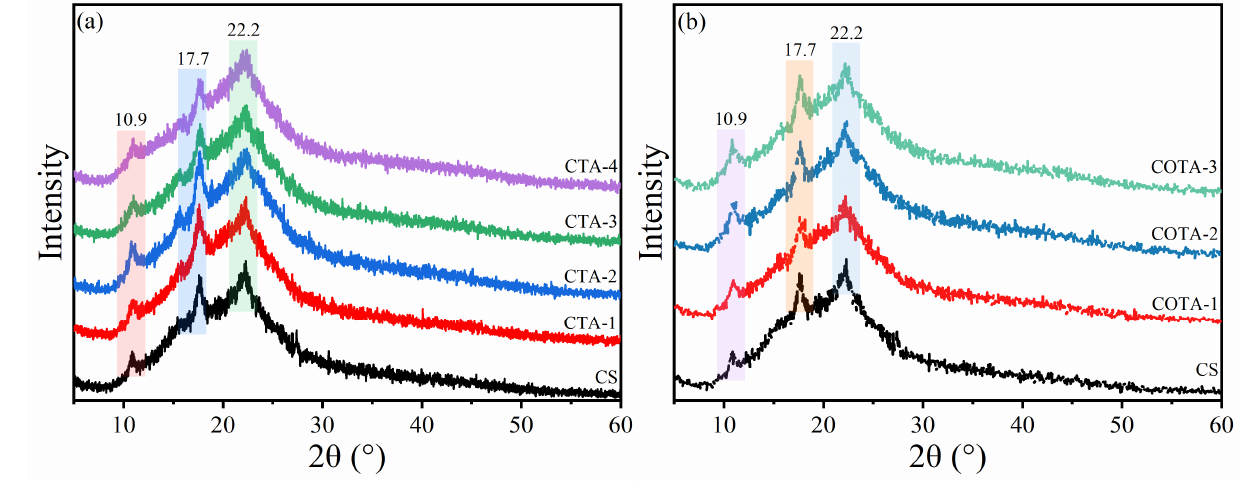
Figure 3. ( a ) The X-ray diffraction patterns for CS and CTA films; ( b ) the X-ray diffraction patterns for CS and COTA films.